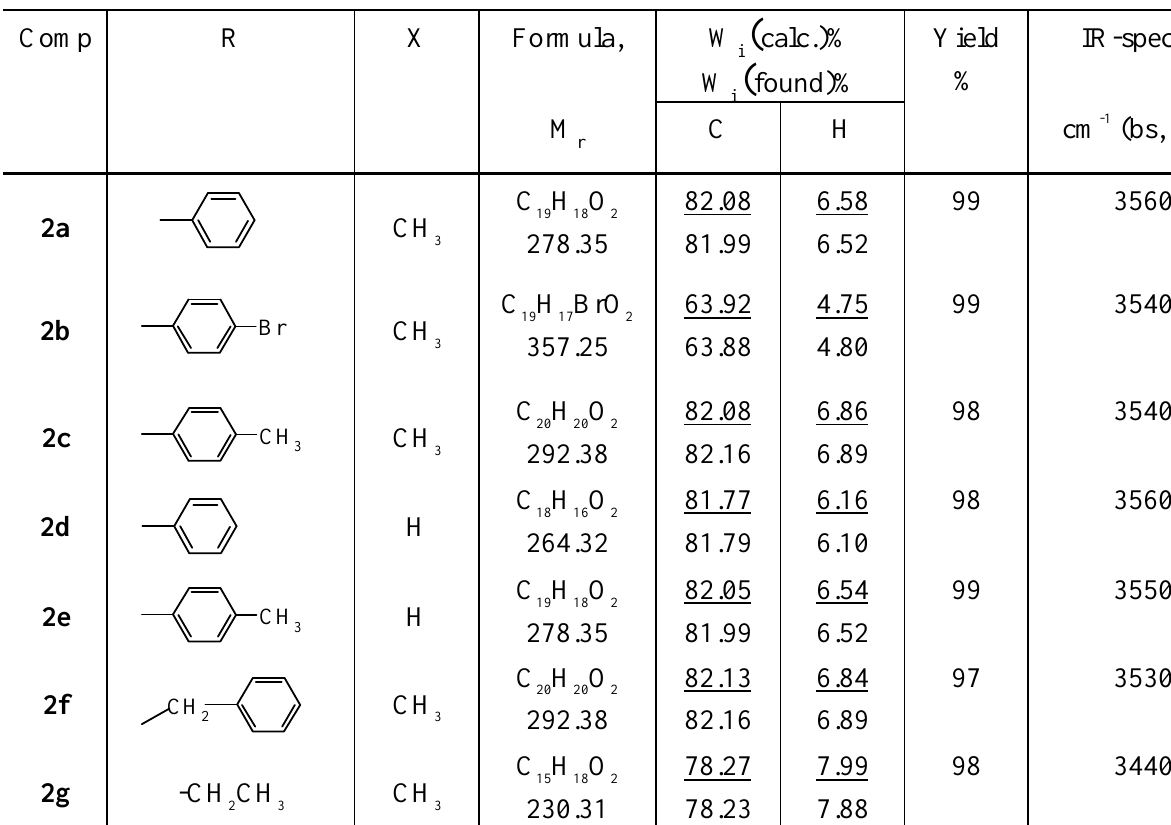
Table 1. Characterization of compounds 2a - g